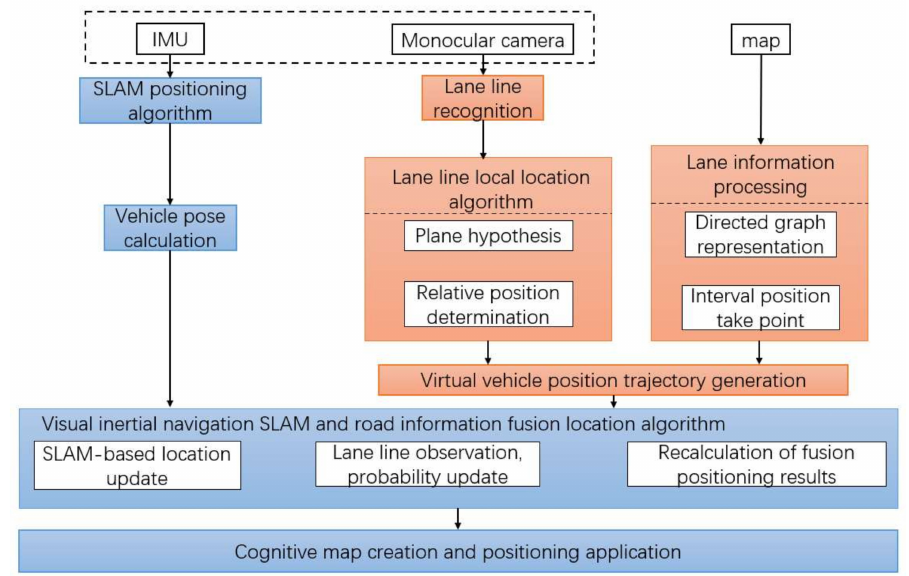
Figure 1. Algorithm flow